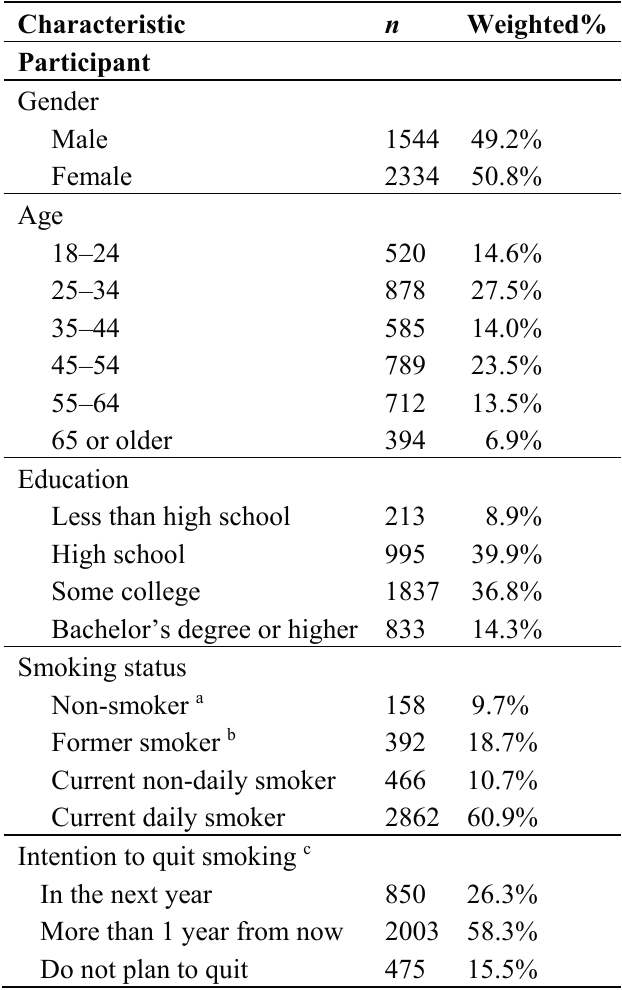
Table 1. Sample characteristics ( n = 3878 e-cigarette ever